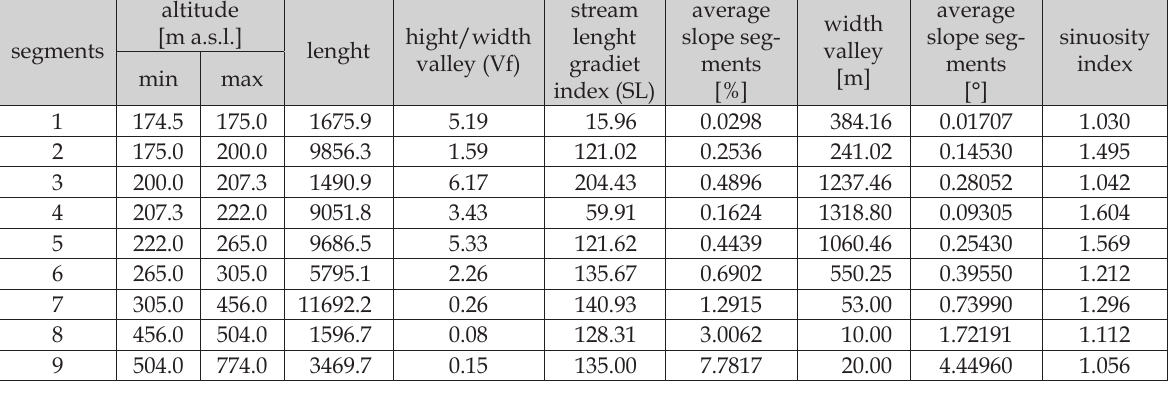
Table 1. Basic parameters of evaluated segments of the longitudinal profile of the Oľšava River. segments